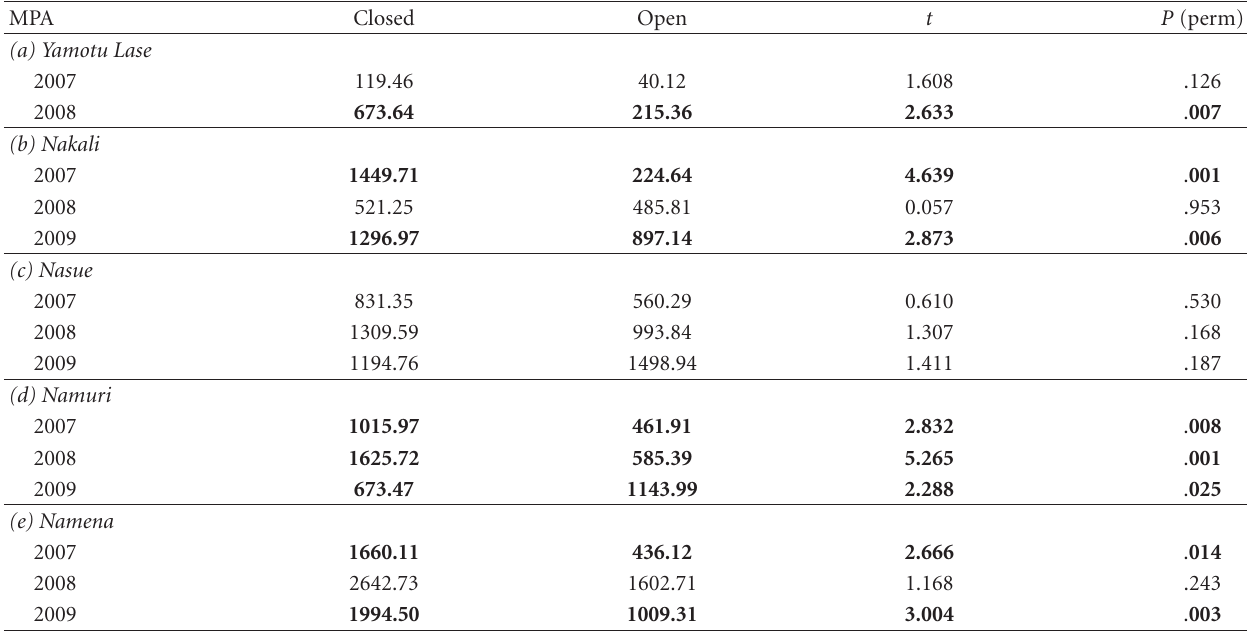
Table 3: PERMANOVA results of di ff erences in fish biomass inside and adjacent to the following MPAs: (a) Yamotu Lase; (b) Nakali; (c) Nause; (d) Namuri; (e) Namena. Mean total fish biomass in closed and open areas is reported in kg/ha. Significant di ff erences of P ≤ . 05 (derived by permutation analysis) are indicated in bold.